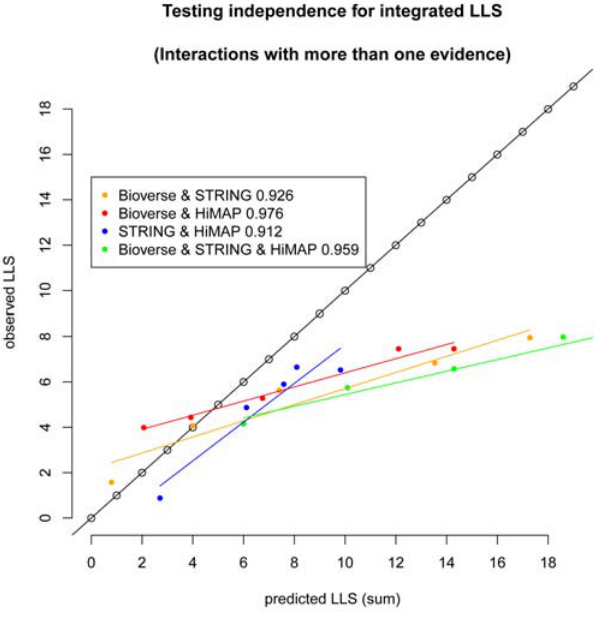
Figure 4. Estimating feature dependencies. The plot of observed versus estimated LLS for all four subgroups of integrated interactions illustrates the dependencies between the three different datasets as well as the linear correlation between predicted and observed log- likelihood scores. The approach is the same in as Figure 3 with the difference that the test set is limited to common interactions. Linear correlation coefficients ( R 2 ) are reported in the legend.